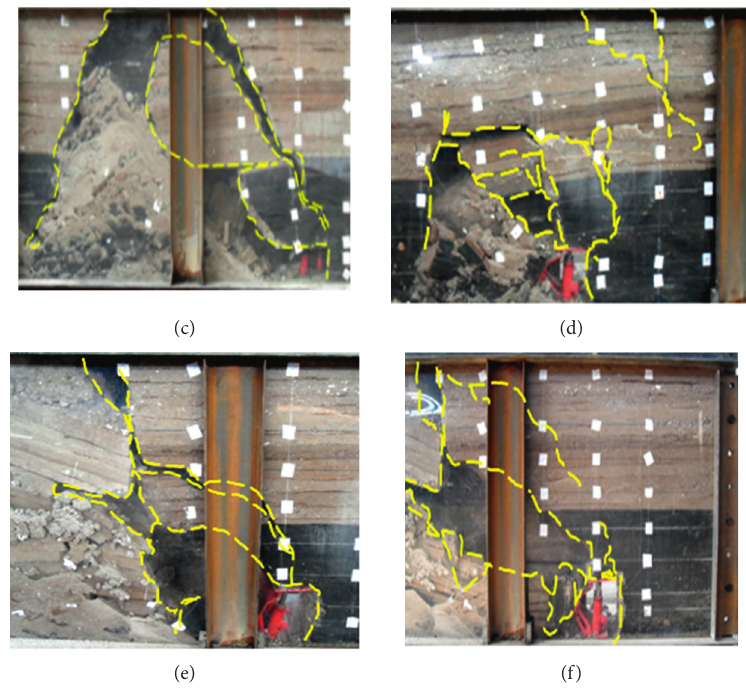
Figure 3: The advanced caving of top